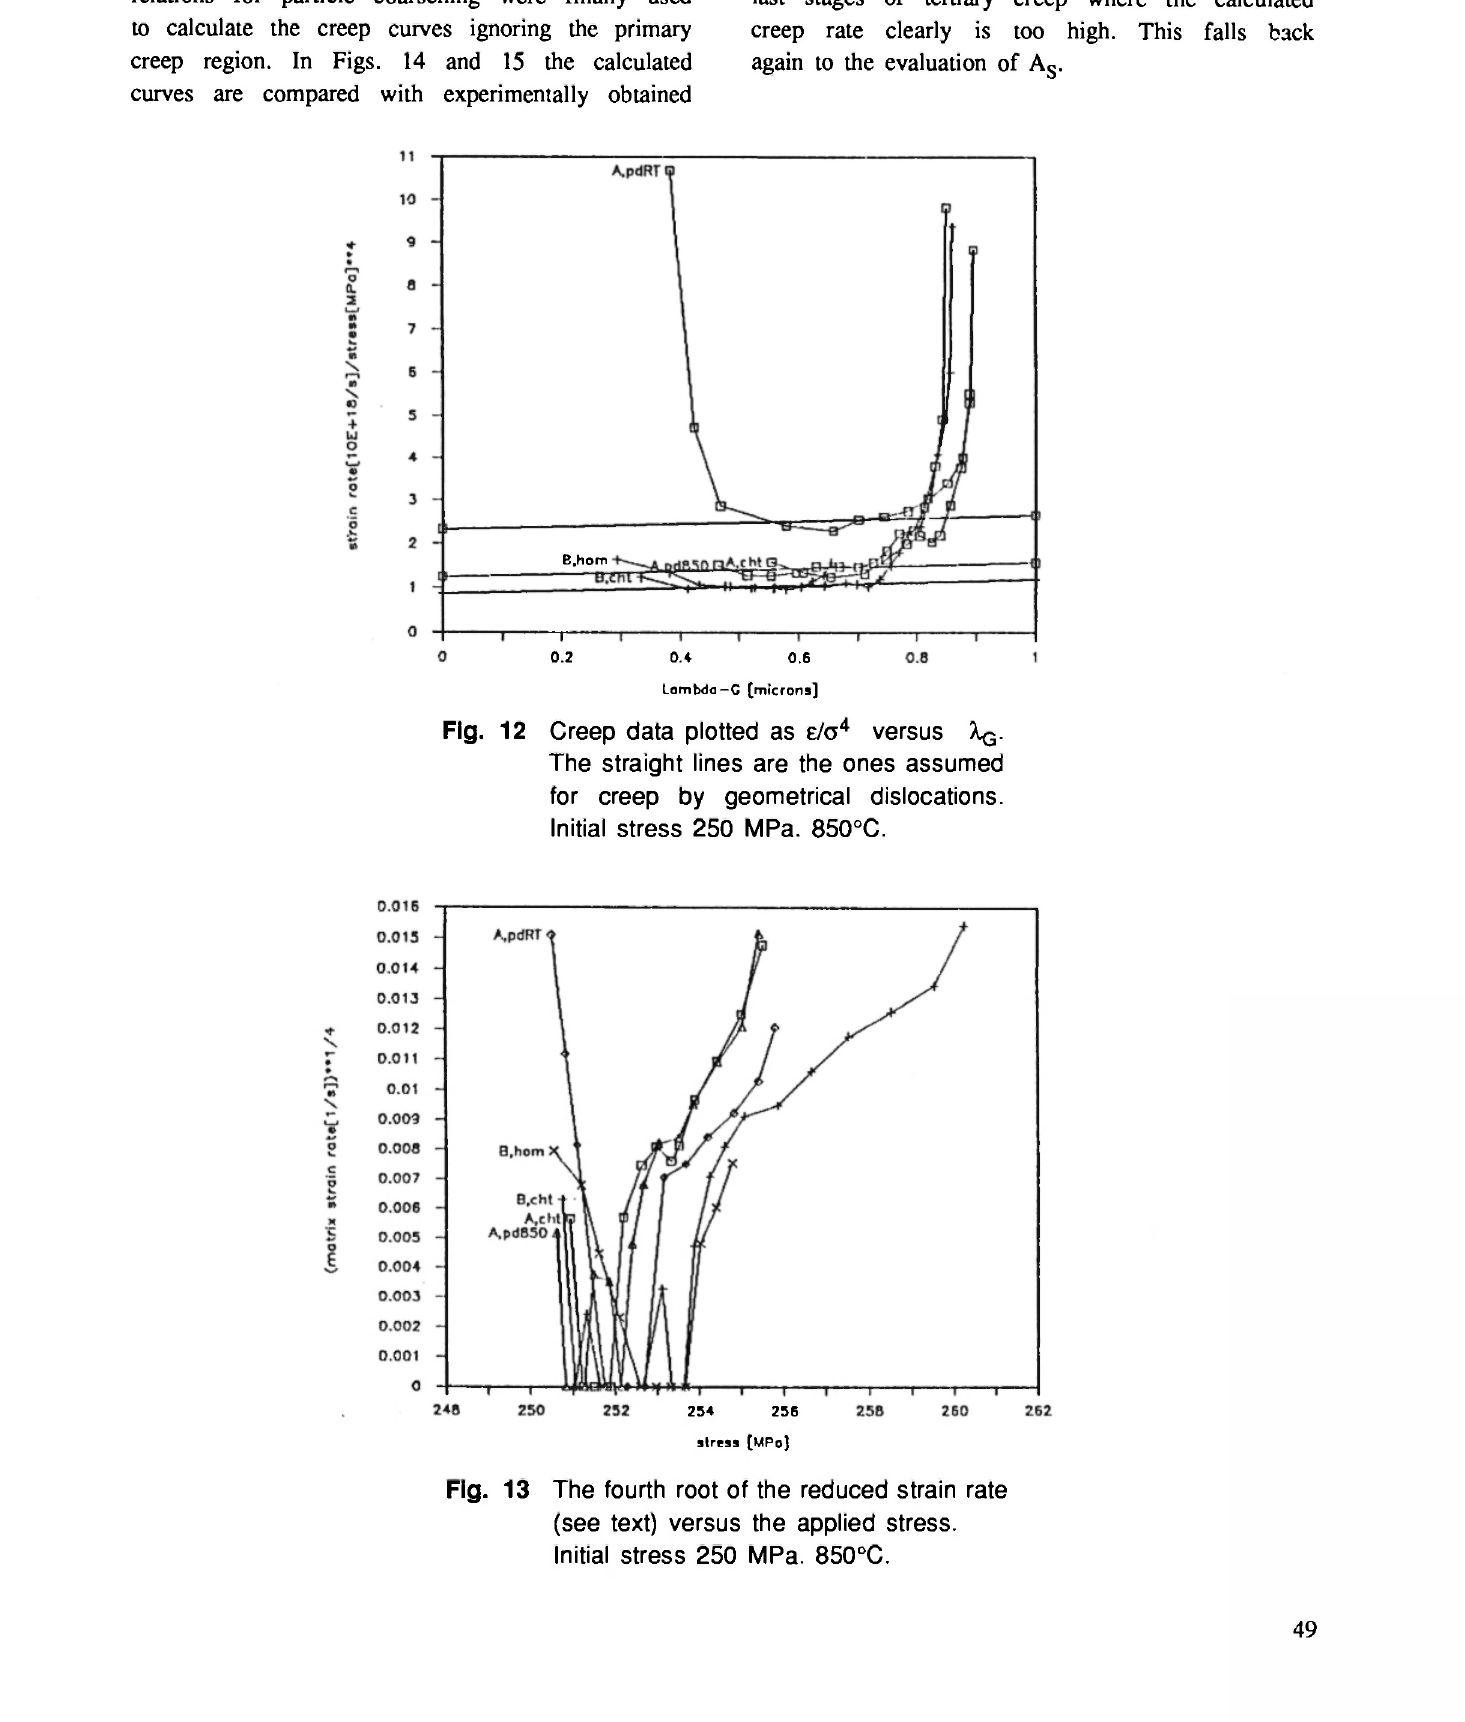
Fig. 13 The fourth root of the reduced strain rate (see text) versus the applied stress. Initial stress 250 MPa.